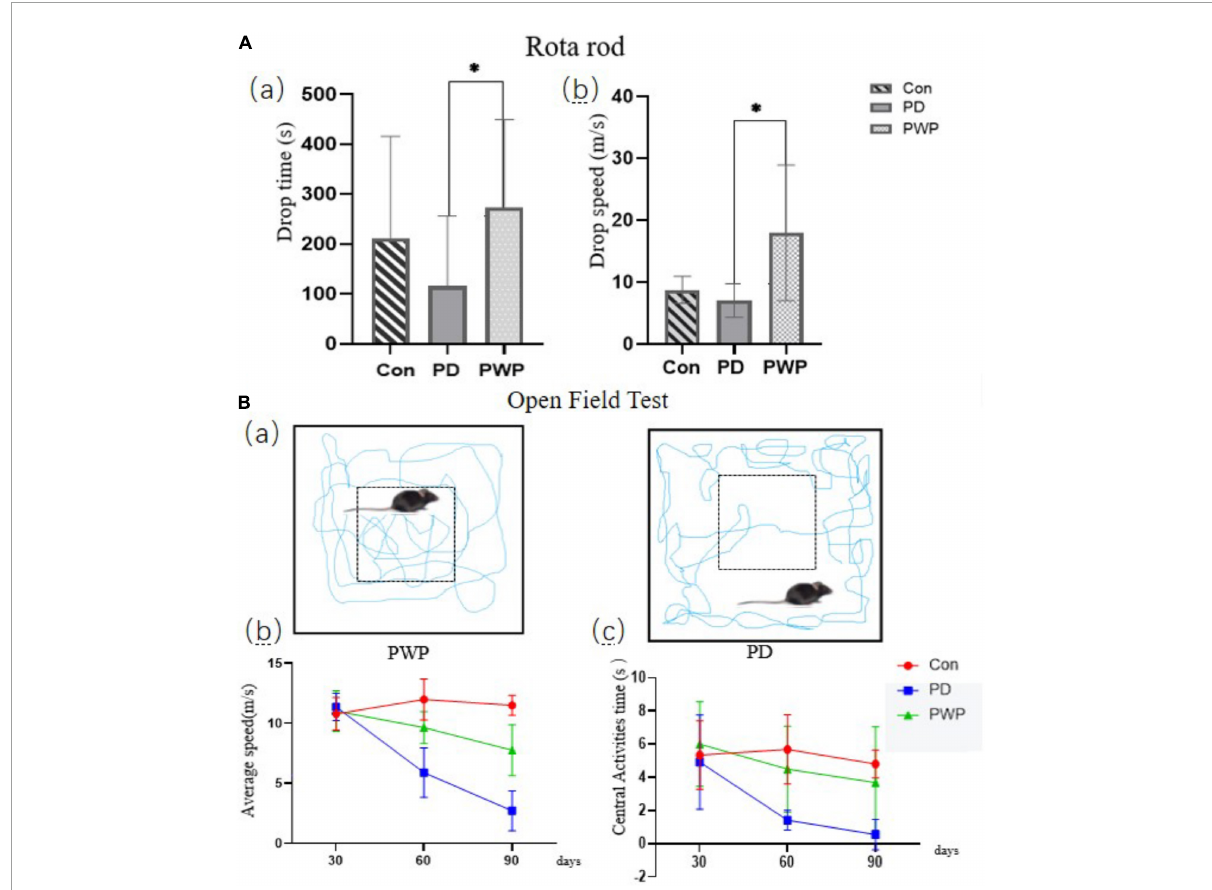
FIGURE2 Behavioral testing. (A) Rota-Rod test performed on the 90th day, including drop time (s) and drop speed (m/s). (B) Open field testing performed on the 30th, 60th, and 90th days; motion track simplified diagram showing PD mice (right) and PWP mice (left) with movement (blue trails) in the peripheral or central regions; test data included average speed and central activities time. *Means that p < 0.1 for significant